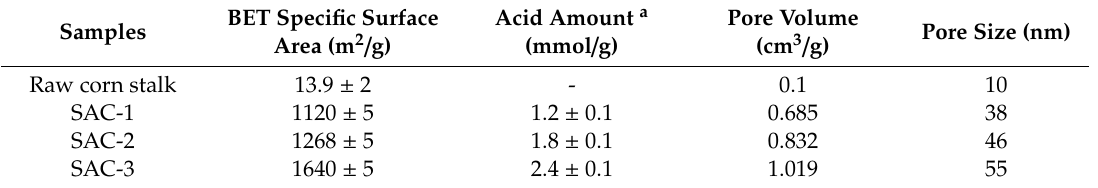
Table 2. Acid amount and specific surface area analysis of biochar-based solid acid catalysts. Samples